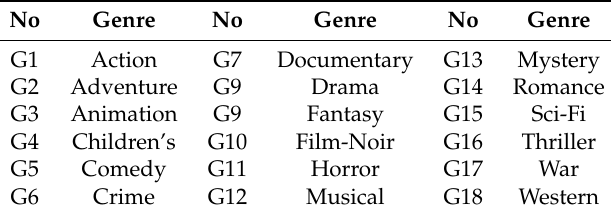
Table 4. The 18 genres in the GroupLens